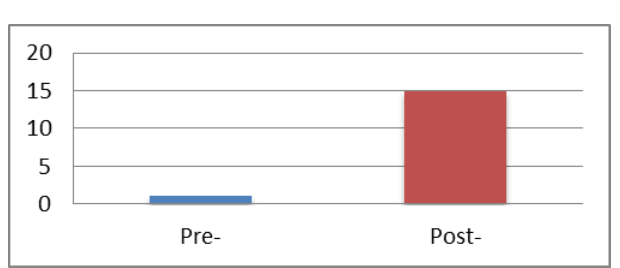
Figure 2. Number of providers who were able to identify four privacy and security factors to consider before and after the in-service